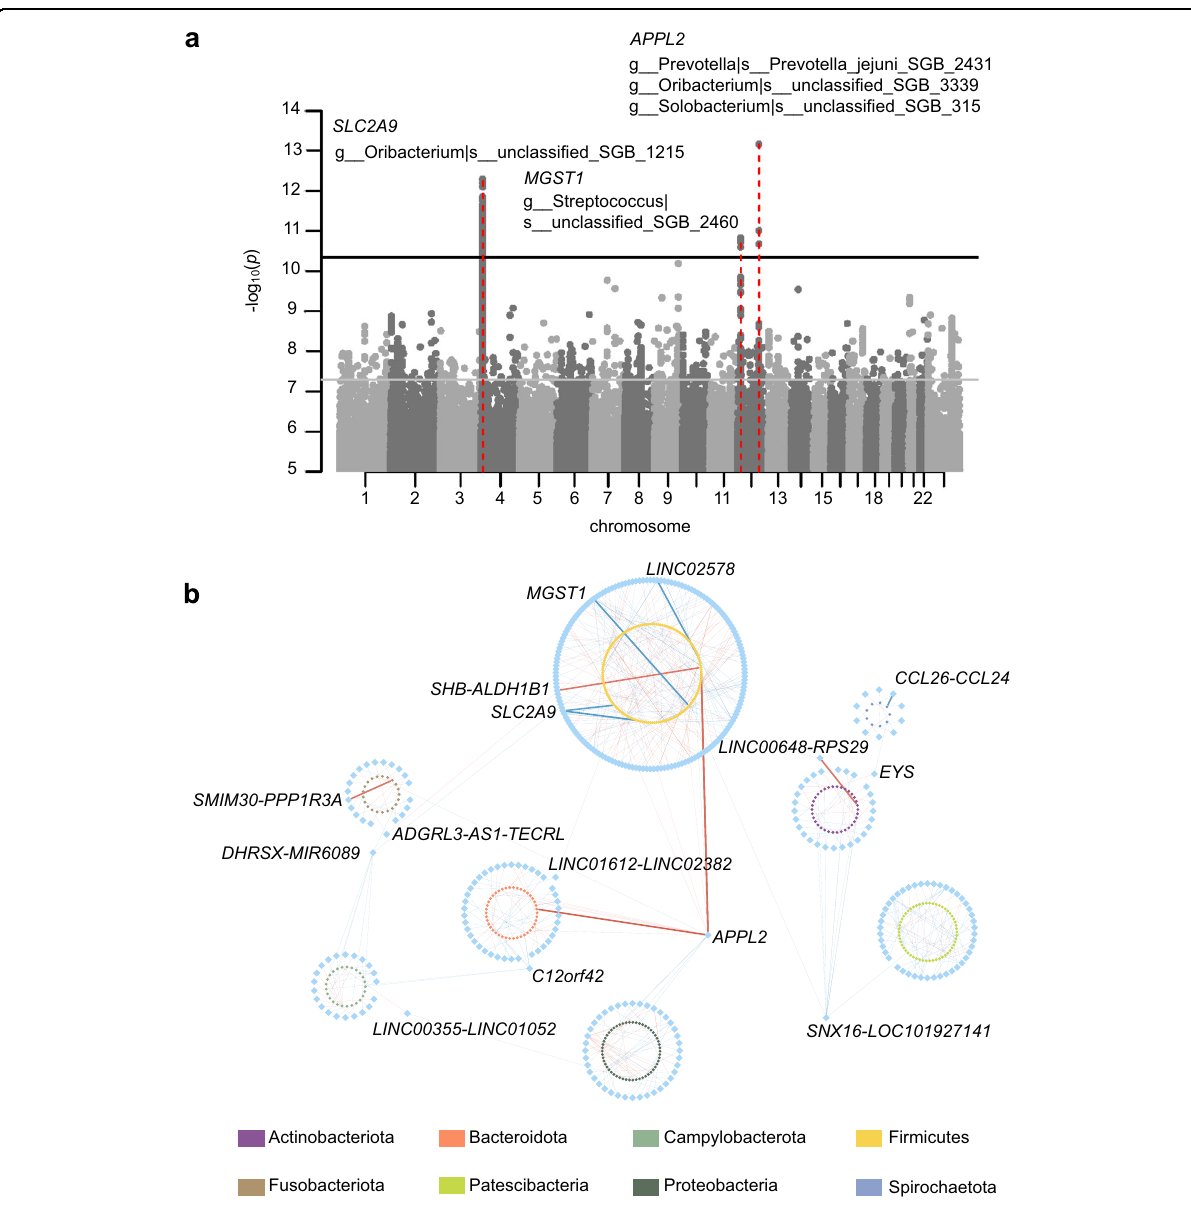
Fig. 1 Host genetic signals associated with the tongue dorsum microbiome. a Manhattan plot shows the genetic variants associated with the tongue dorsum microbial taxa. The horizontal gray and black lines represent the genome-wide ( p = 5 × 10 − 8 ) and study-wide ( p = 3.16 × 10 − 11 for 1583 independent mgGWAS tests) signi fi cance levels, respectively. Three loci that were associated with the tongue dorsum microbiome and reached study-wide signi fi cance were marked in red. Their located genes and associated microbial taxa with p values of < 3.16 × 10 − 11 were also listed. b Network representation of the 455 gene-microbiome associations identi fi ed in the tongue dorsum mgGWAS at the genome-wide signi fi cance. Each node represents either a gene (blue diamonds) or a microbial taxon (circles with different colors according to phylum). Each edge is an association between one gene and one microbial taxon. The bold edge represented study-wide signi fi cant associations as shown in a . The genes that linked to at least two different microbial taxa from different phyla were also